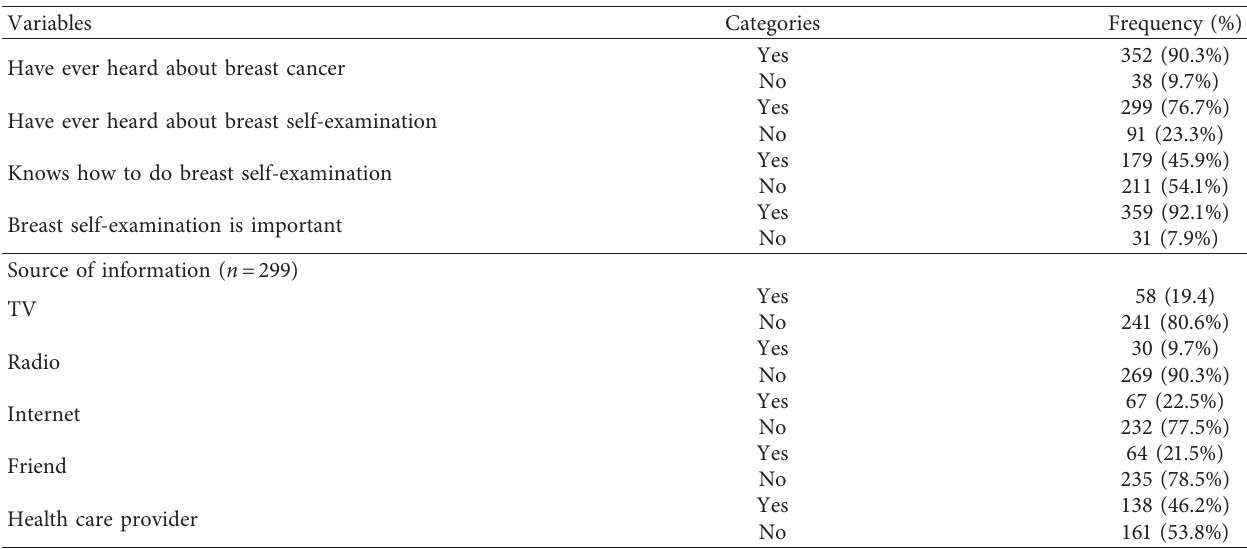
Table 2: Awareness of breast cancer and knowledge of BSE.